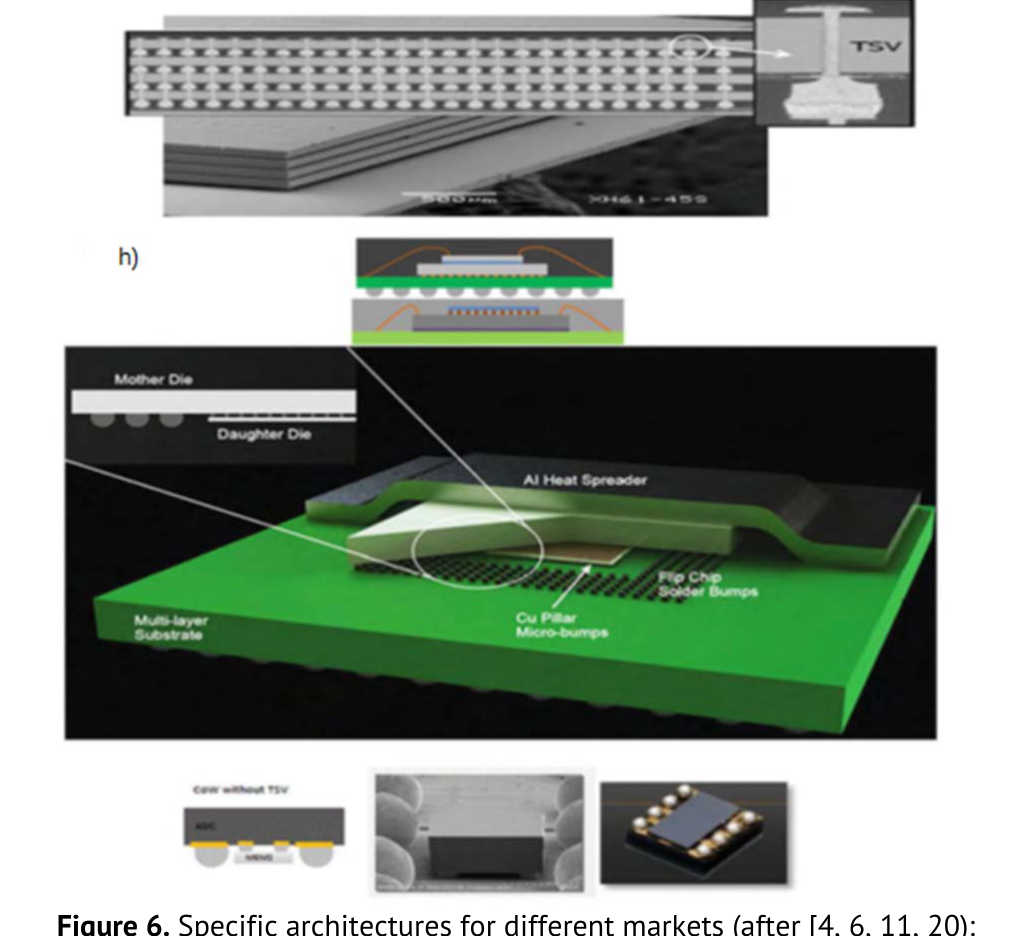
Figure 6. Specific architectures for different markets (after [4, 6, 11, 20): (a) Multi Chip Module (MCP); (b) Multi Package module (MPM) (c) Embedded SIP modules; (d) SIP package-on-package (PoP) modules (e) EMIB (Embedded Multi-die Interconnect Bridge); (f) Silicon-based SIP-Module; (g) 3D-TSV stacked module; (h) SIP variants with combinations of wideband and flip-chip